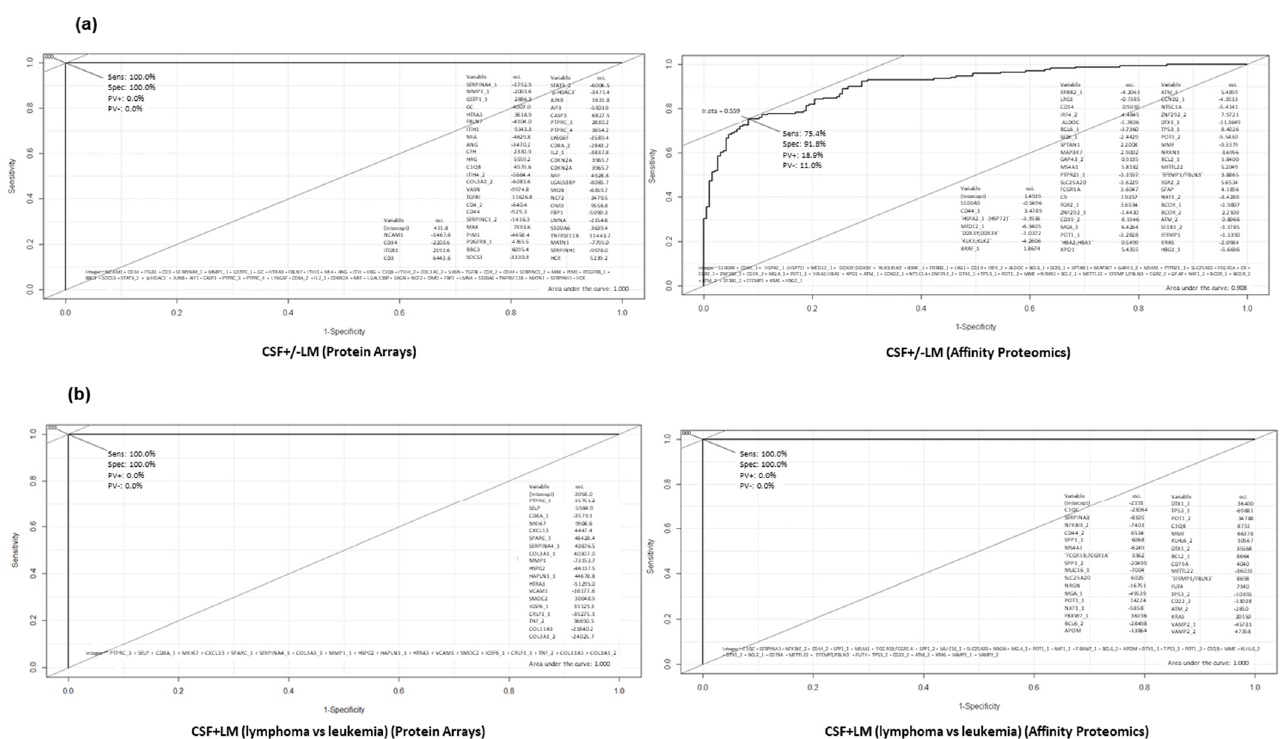
Figure 7. ( a ) ROC analysis for a potential biomarker panel on CSF +/ − LM by protein arrays and affinity proteomics (as described in Materials and Methods section). ( b ) ROC analysis for potential biomarker panel within the CSF + LM group to distinguish between the causes of the metastasis (lymphoma vs. leukemia) by protein arrays and affinity proteomics (as described in Materials and Methods section).